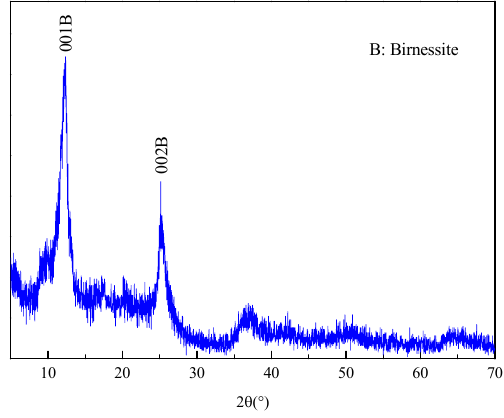
Figure 1. The XRD pattern of Mn